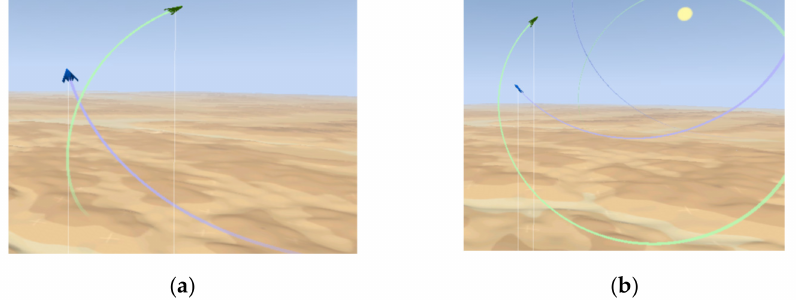
Figure 12. Blue UCAV chasing the green target moving in the vertical plane: ( a ) early stage of air combat; ( b ) later stage of air